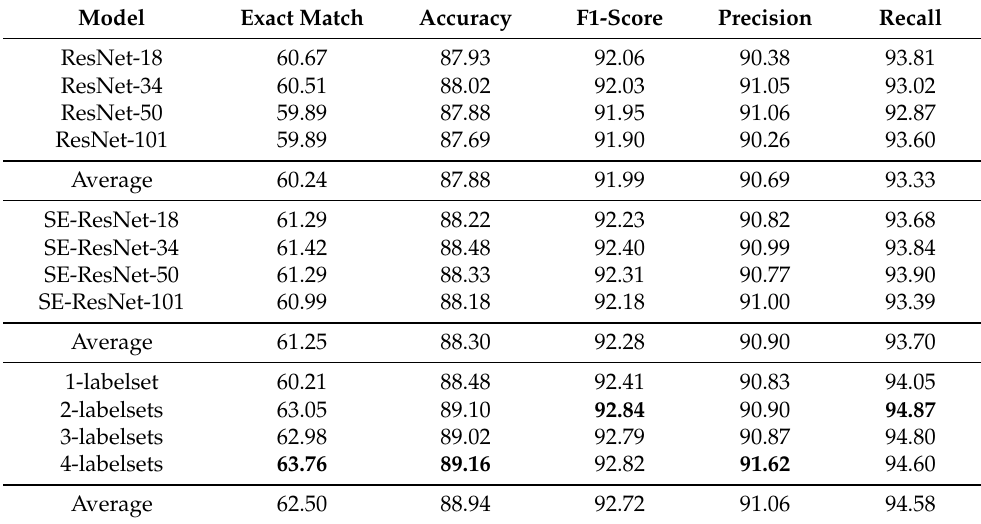
Table 3. Classification performance for each model based on superclass (the proposed model with k -labelsets uses SE-ResNet-34 as a